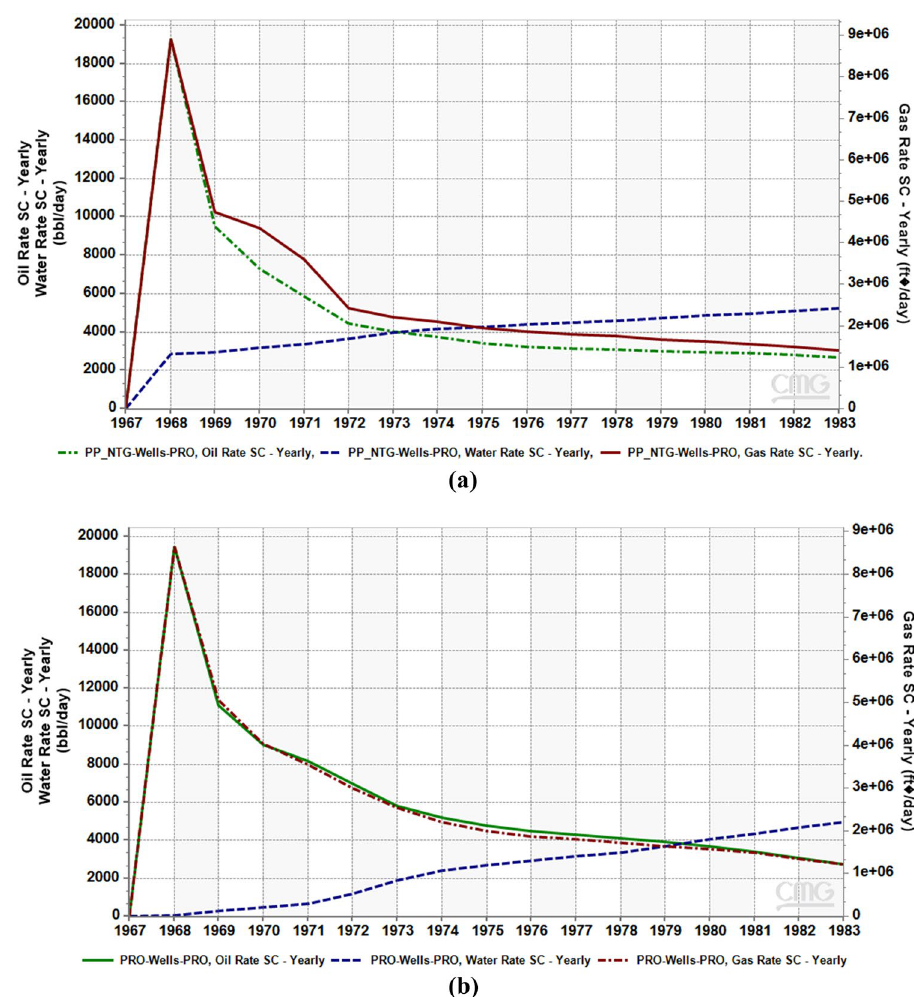
Fig. 12 Oil, water and gas rates for PRO-Wells ( a ) and PP_NTG-Wells ( b